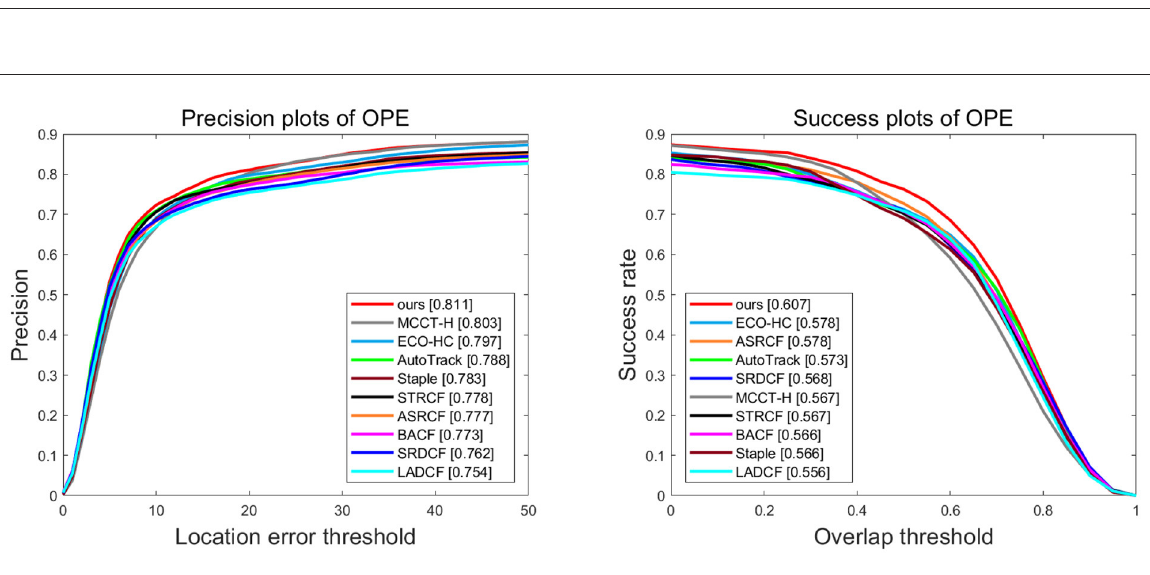
FIGURE2 Overall performance of ten trackers on Visdrone2018-test-dev. The legend of success plot represents the area under the curve score of each tracker. The legend of the precision plot refers to threshold scores at 21 pixels.